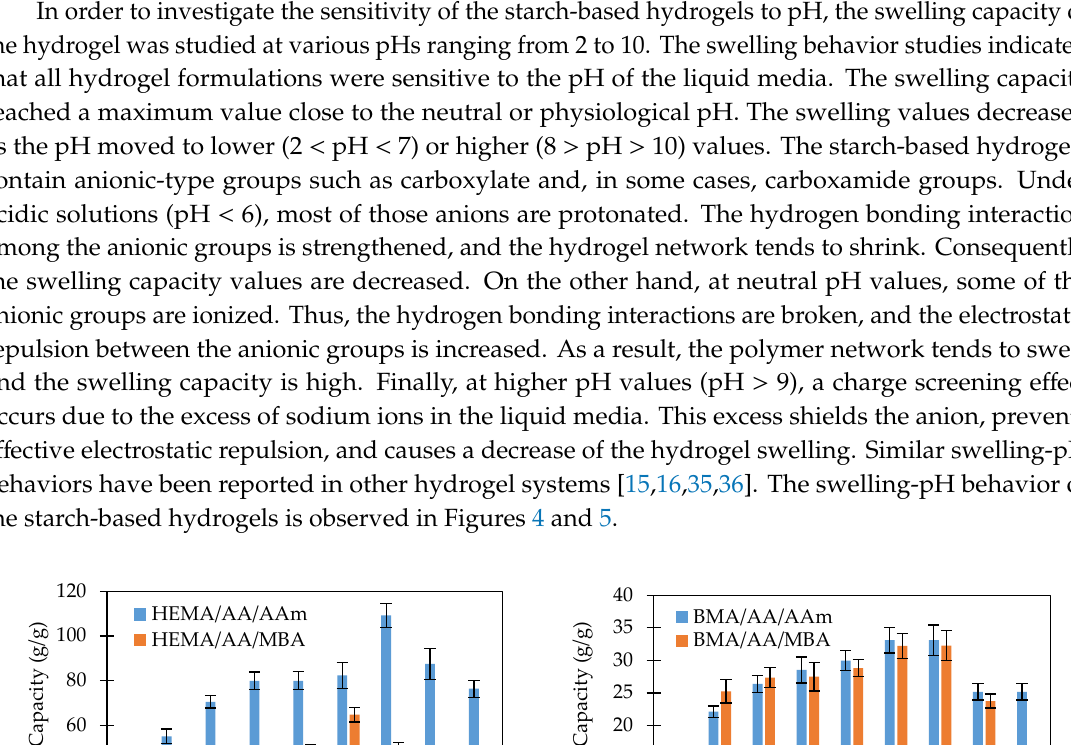
Figure 5. Storage modulus ( G ′) and loss modulus ( G ″) of the hydrogels as a function of the angular frequency. 3.3.3. Effect of the Hydrophilic/Hydrophobic Monomers on the Swelling Behavior The effect of the hydrophilic/hydrophobic character of the monomers on the swelling behavior of the copolymers was evaluated by comparing the swelling capacity of hydrogels with and without the hydrophobic BMA monomer. In Figure 6, it can be observed that the hydrogels synthesized with HEMA as the comonomer (HEMA/AA/AAm and HEMA/AA/MBA) exhibited a greater swelling capacity when compared to those produced with BMA as the comonomer (BMA/AA/AAm and BMA/AA/MBA). This behavior is explained by the chemical structure of both monomers. HEMA has –OH groups, which makes it hydrophilic and gives the copolymer the ability to create hydrogen bonds with water molecules. In contrast, the non polar BMA units inhibit the interaction with water, restrain the expansion of the hydrogel networks, and consequently decrease the water uptake.